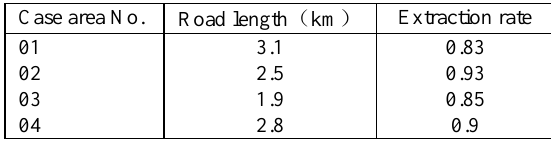
Table 13. Evaluation of linear marking of case area. Table 14 was the evaluation of arrows. The total number of